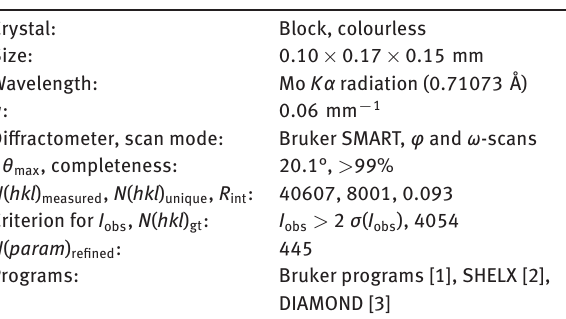
Table 1: Data collection and